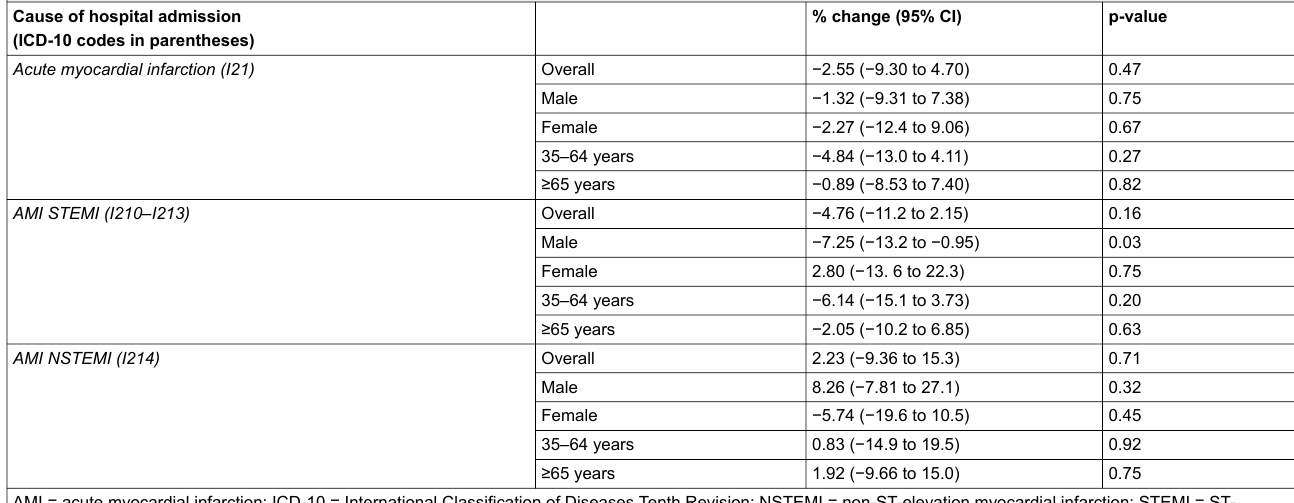
Table S5: Gender- and age-specific estimates in change in risk (and 95% confidence interval) of hospital admission in adults (≥35 years old) due to acute myocardial infarction (total, with ST-elevation, without ST-elevation) after the introduction of the smoking ban (data restricted to period of 2 years before and 2 years after the introduction of the smoking ban in each canton).